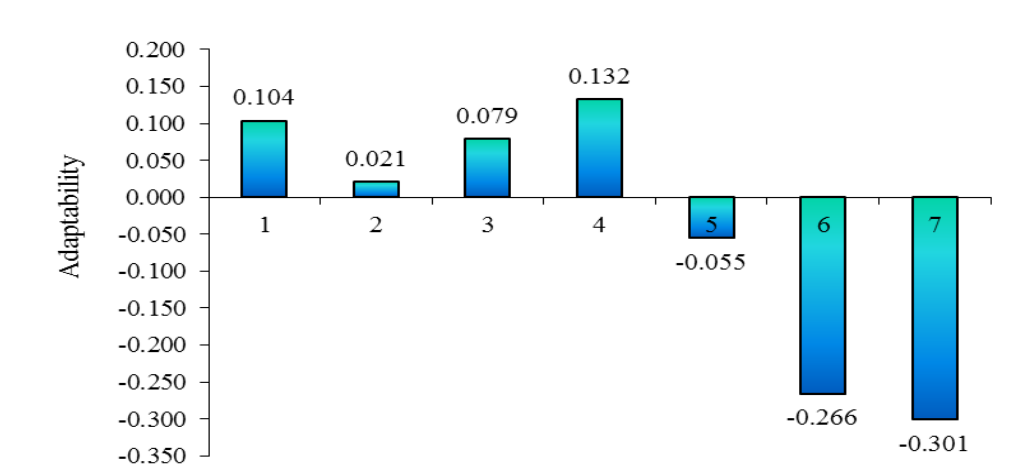
Fig. 3. Total adaptive ability (А) (Valchinkov, 1990) of the studied swards; 1-‘Pleven 6’, 2-‘Prista 2’, 3-‘Multifoliate’, 4-alfalfa local population LP1, 5-alfalfa local population LP2, 6-local population of birdsfoot trefoil, 7-local population of red